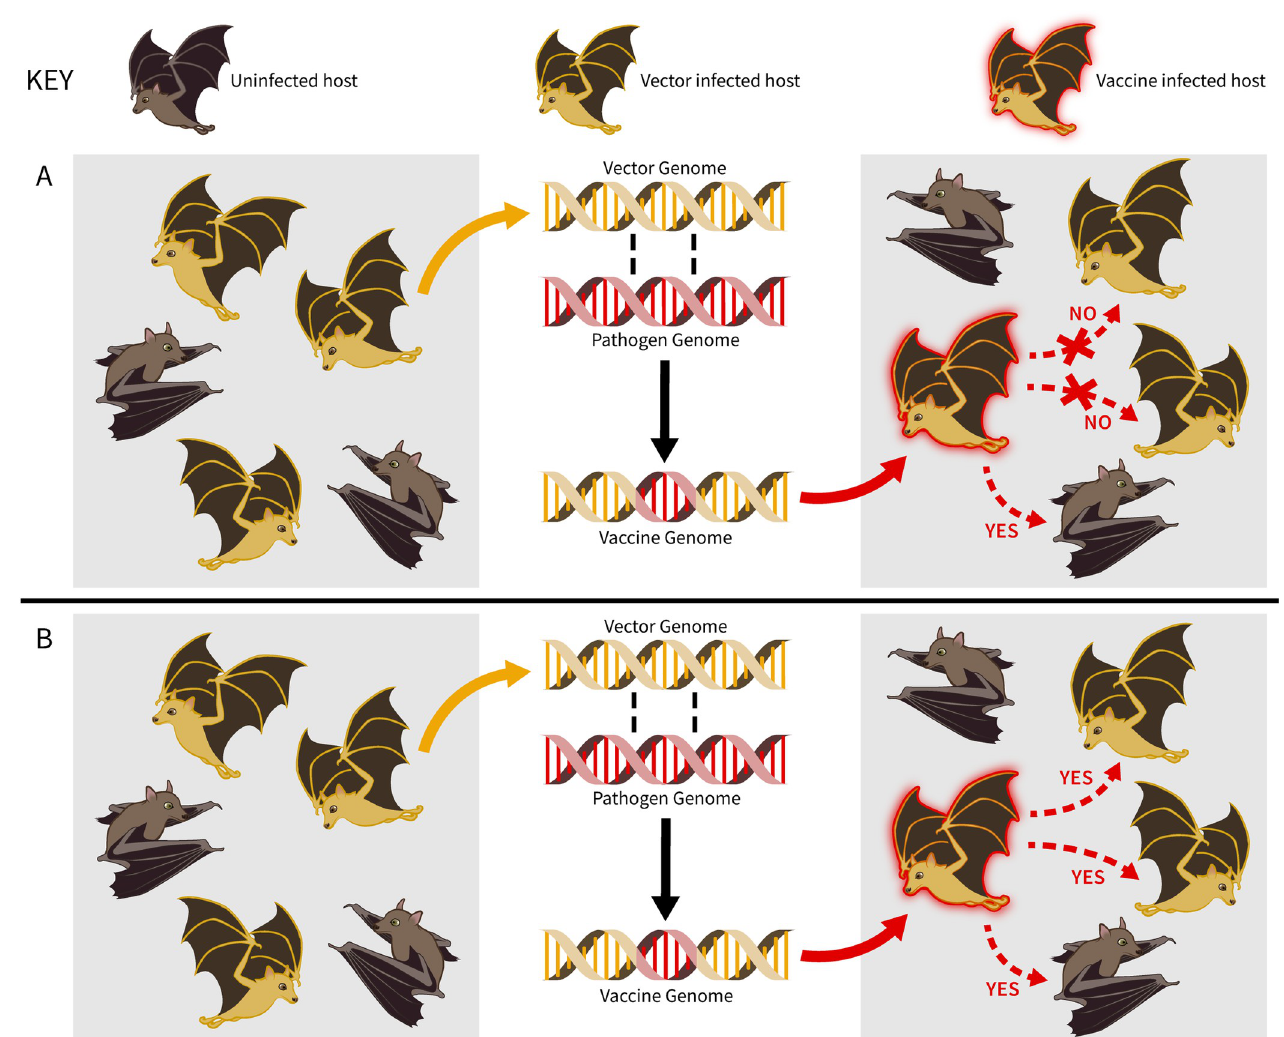
Fig 1. A recombinant vector transmissible vaccine is constructed by isolating the vector virus from a population of the animal reservoir in which it naturally circulates (left-hand panels). The vector virus is brought back to the lab where it is engineered to carry a gene of the pathogen that stimulates an immunizing response within the reservoir (center panels). The newly created transmissible vaccine is then released back into the population from which the vector virus was isolated (right-hand panels). If prior infection of reservoir animals by the naturally circulating vector virus blocks reinfection by the vaccine, the gains made by vaccine transmission will be minimal (top row, A). In contrast, if the vaccine can reinfect animals previously infected with the naturally circulating vector virus, the gains made by vaccine transmission can be substantial (bottom row,